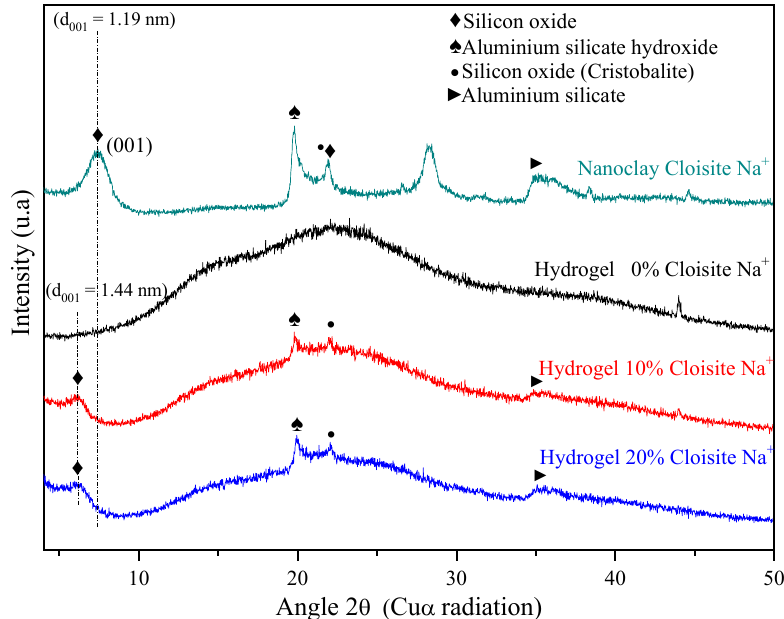
Figure 3. X-ray diffraction for PAAm/MBAAm/CMC + Cloisite Na + swollen in distilled water. XRD patterns of hydrogel pure (PAAm and CMC) and hybrid nanocomposite hy- drogels (PAAm/CMC and Cloisite Na + ) confirmed that these matrices are predominantly amorphous, as expected due to their chains have high crosslinking density. However, it is possible to observe, from hybrid hydrogels XRD, that the characteristic nanoclay peak (2θ = 7.36°) shifted to the small angle of the 2θ = 6.28°, causing an increase in basal spacing (d 001 = 1.44 nm). This increase indicated the intercalation of nanoclay Cloisite Na + in the